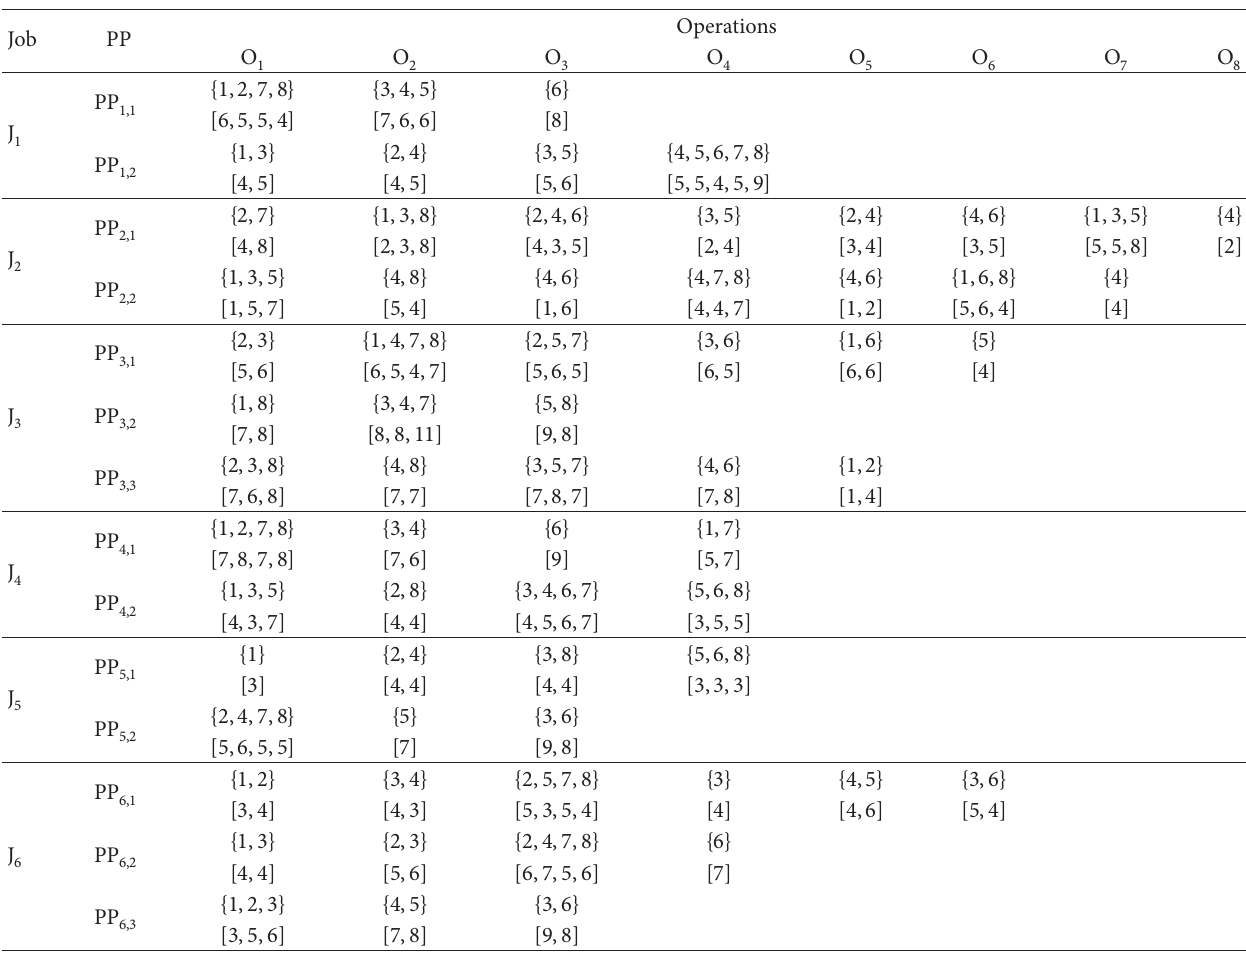
Table 1: Input data for 6 × 8 problem.